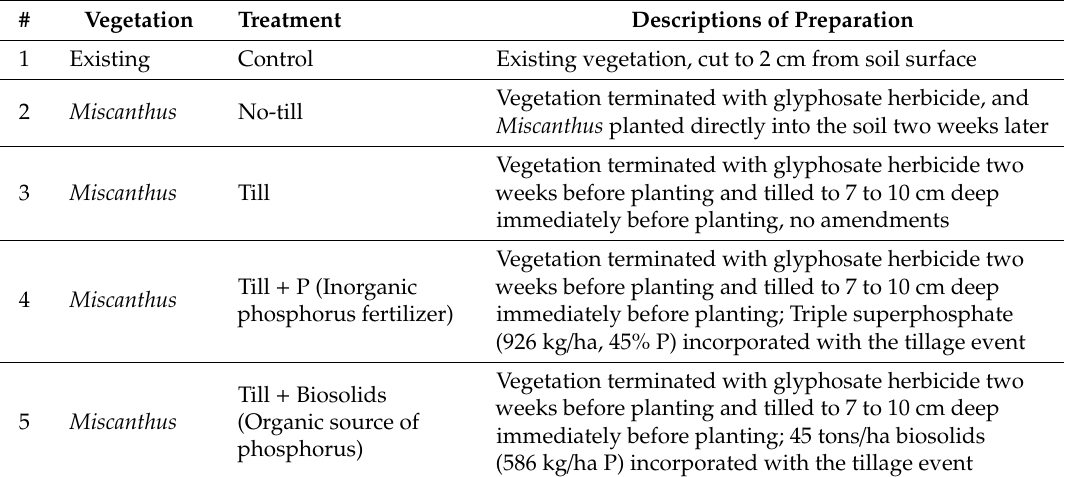
Table 1. Agronomic practices imposed for 2016 planting of long term Miscanthus planting on a Pb contaminated site at Ft. Riley, Kansas [10].